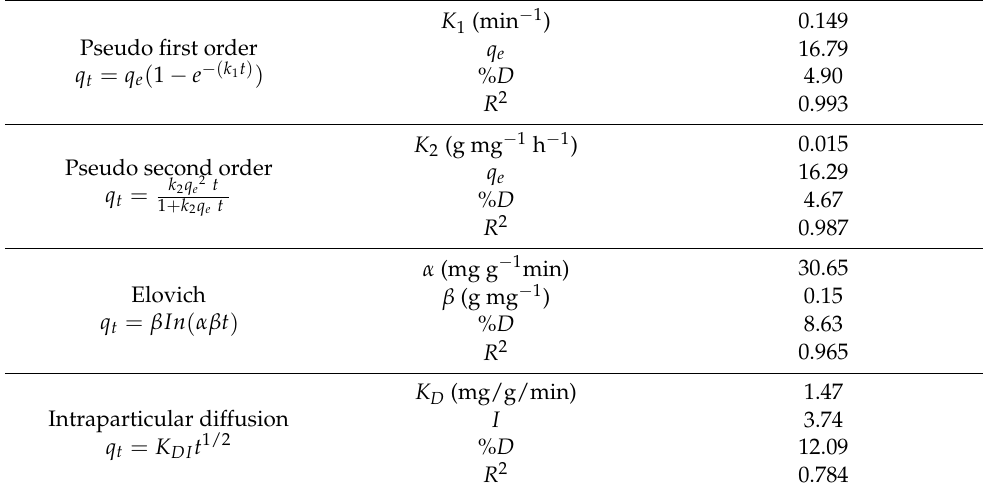
Figure 15. Adsorption of Cd(II) on alumina spheres at 1600 °C: ( A ) Adsorption kinetic models, ( B ) Adsorption equilibrium isotherm. Table 3. Calculated kinetic parameters of Cd(II) adsorption on Al 2 O 3 spheres.